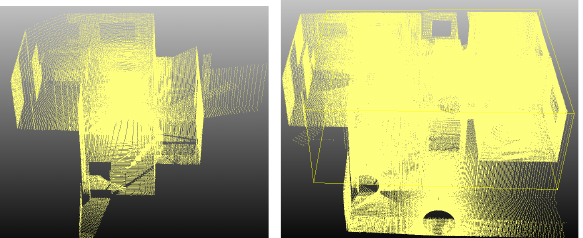
Fig. 4. Left: point cloud of a single scan; right: point clouds of seven scans combined